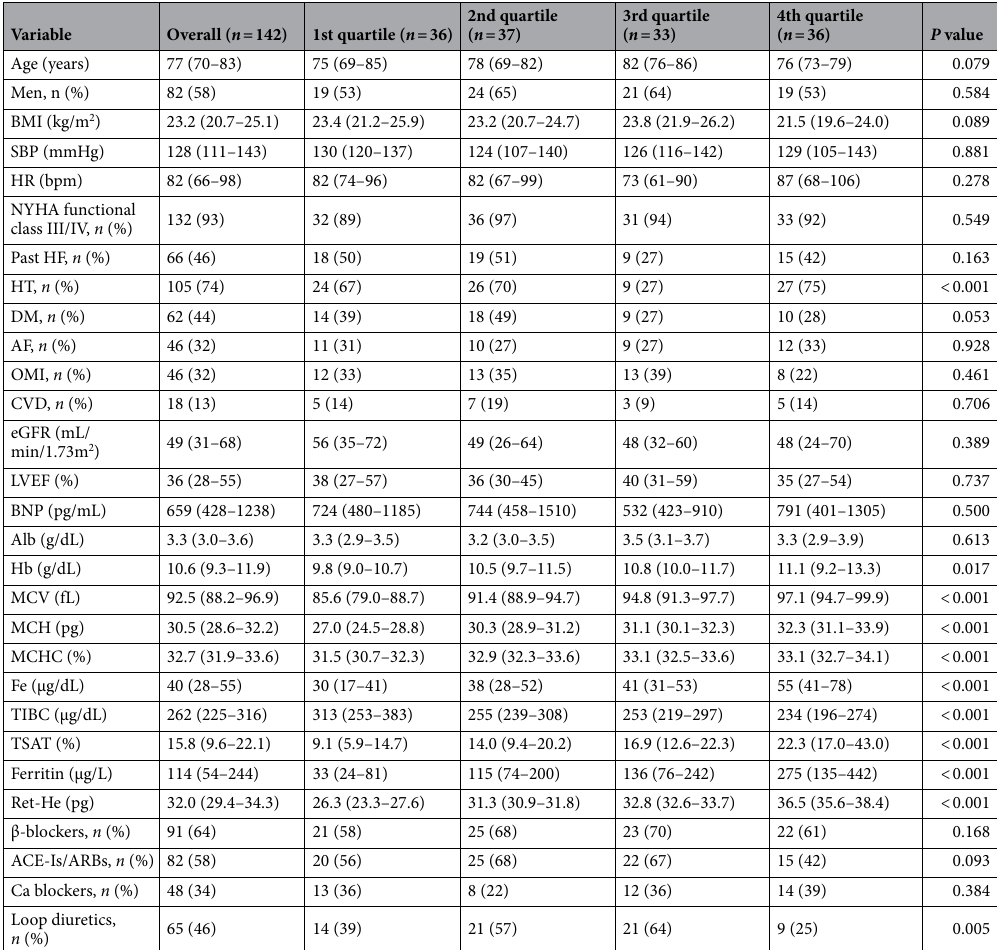
Table 1. Patient characteristics on admission according to quartile of Ret-He levels. Continuous variables are presented as median and interquartile range, and categorical variables are presented as number (percentage). BMI body mass index, SBP systolic blood pressure, HR heart rate, Past HF past hospitalization for heart failure, HT hypertension, DM diabetes mellitus, AF atrial fibrillation, OMI old myocardial infarction, CVD cerebrovascular disease, eGFR estimated glomerular filtration rate, LVEF left ventricular ejection fraction, BNP brain natriuretic peptide, Alb albumin, Hb hemoglobin, MCV mean corpuscular volume, MCH mean corpuscular hemoglobin, MCHC mean corpuscular hemoglobin concentration, TIBC total iron binding capacity, TSAT transferrin saturation, Ret-He reticulocyte hemoglobin equivalent, ACE-I angiotensin- converting enzyme inhibitor, ARB angiotensin II receptor